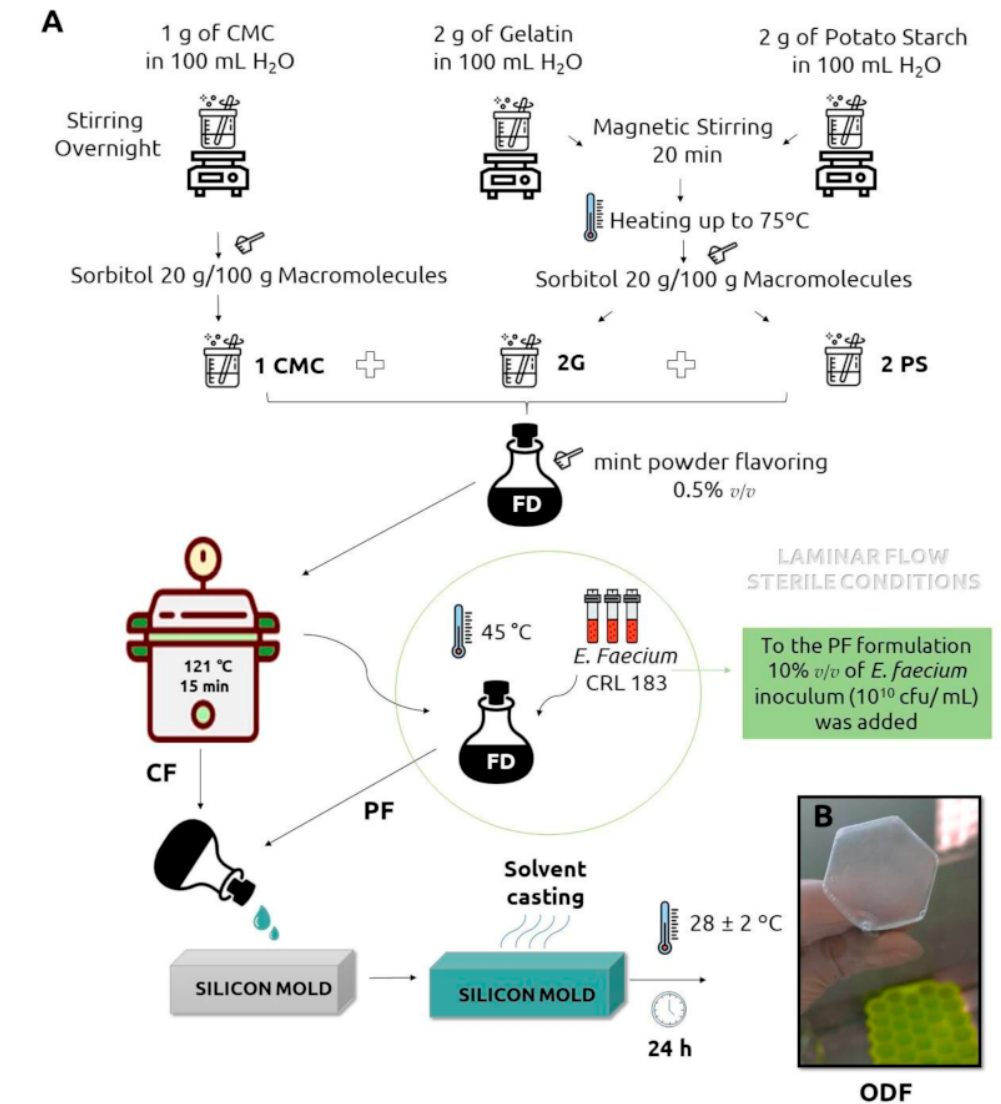
Figure 4. ( A ) Preparation protocol of ODF ( B ) containing Enterococcus faecium [20]. Table 3. Discontinued ODFs.